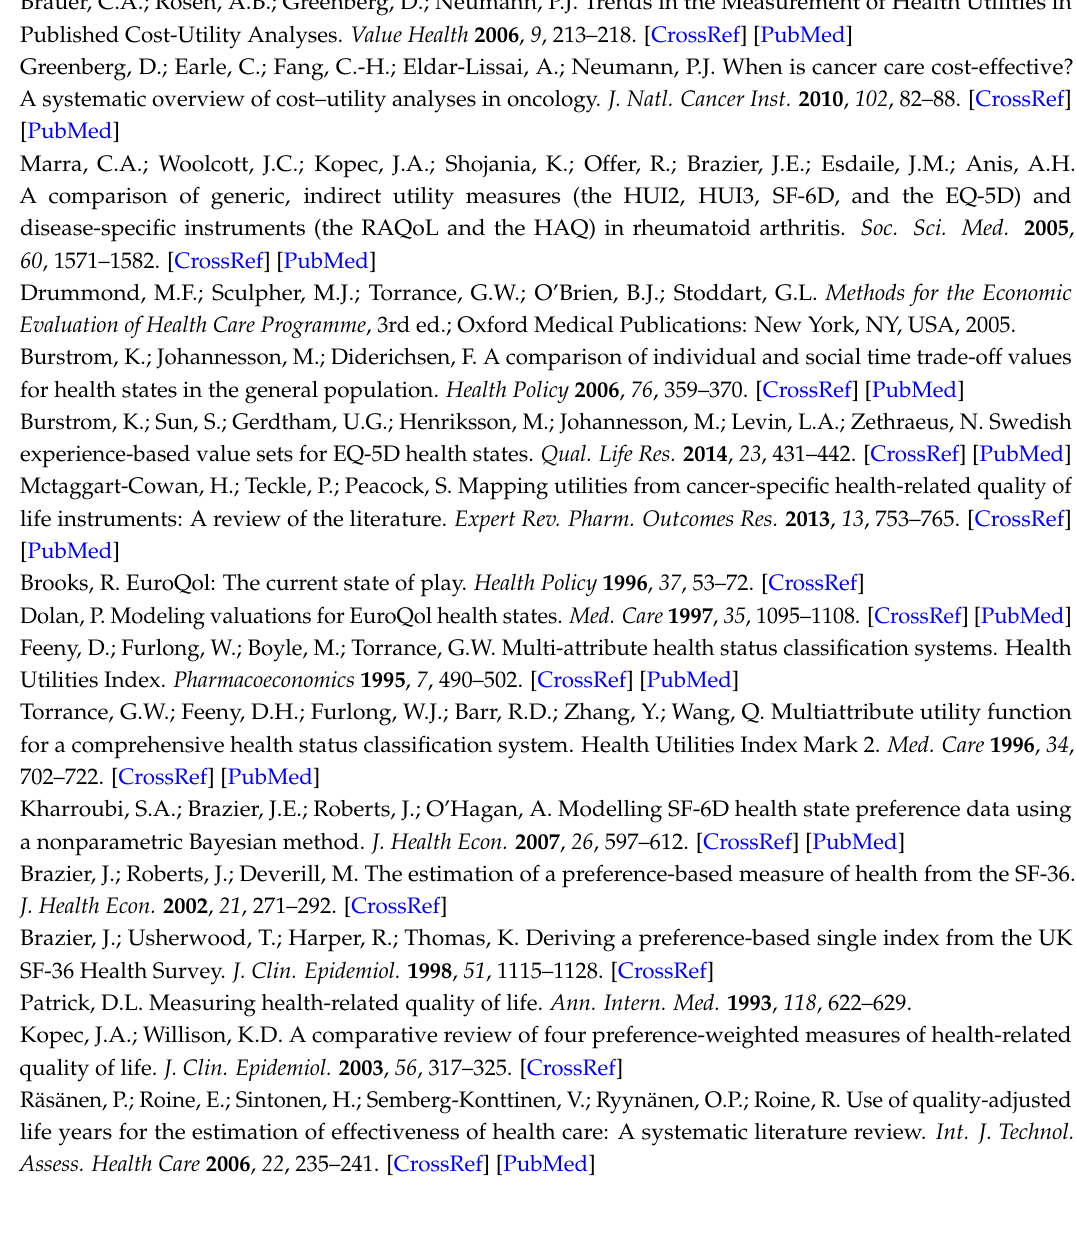
Table S1: Factors associated with EQ-5D index scores—results of Tobit regression